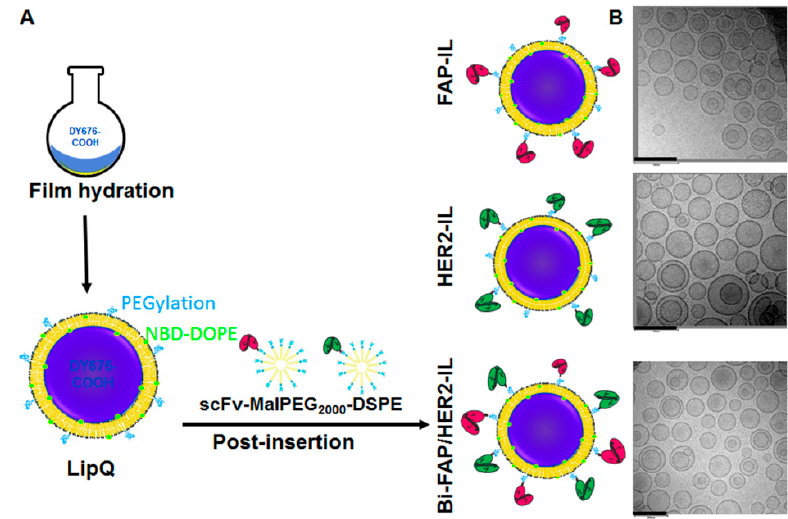
Figure 1. Scheme of the workflow for the liposomal preparation ( A ) and representative electron micrographs of the resulting quenched/activatable liposomes ( B ). Scale bar: 200 nm.